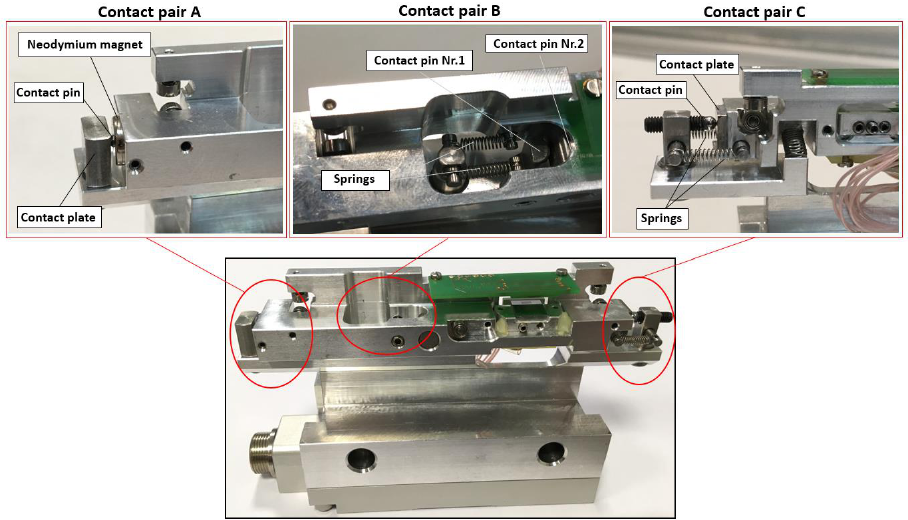
Figure 3. The experimental reading head of the linear encoder with detailed views of three different mechanical designs: contact pair A, contact pair B and contact pair C.